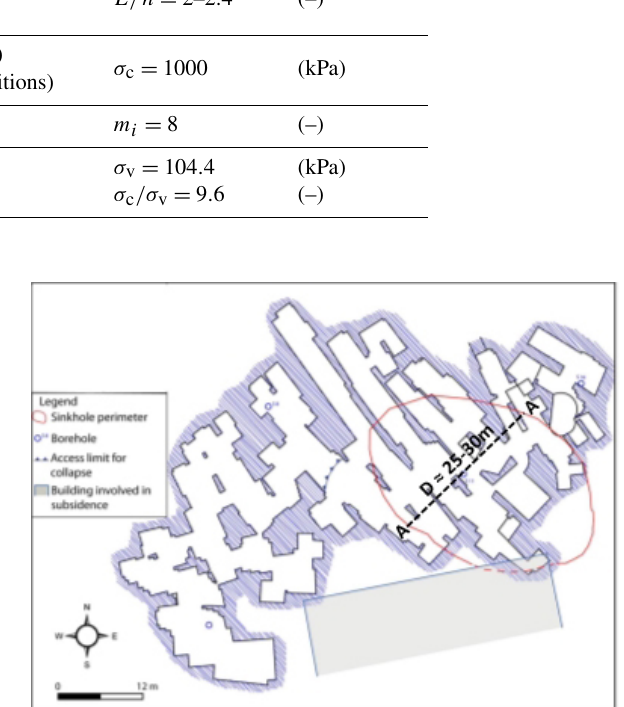
Figure 9. Plan of the Marsala underground quarry, with indication of the sinkhole area (adapted from Vattano et al.,